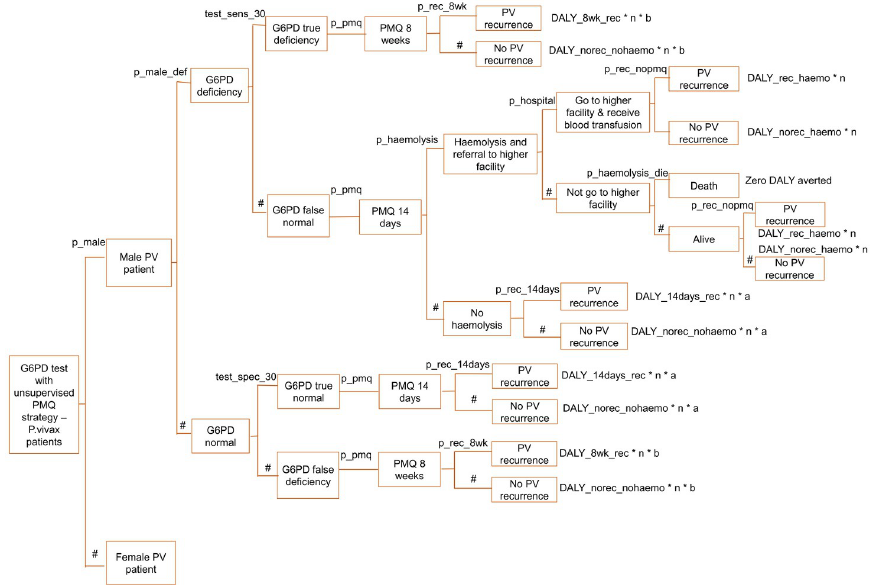
Fig 3. Decision tree model for G6PD test with unsupervised PMQ strategy—Male